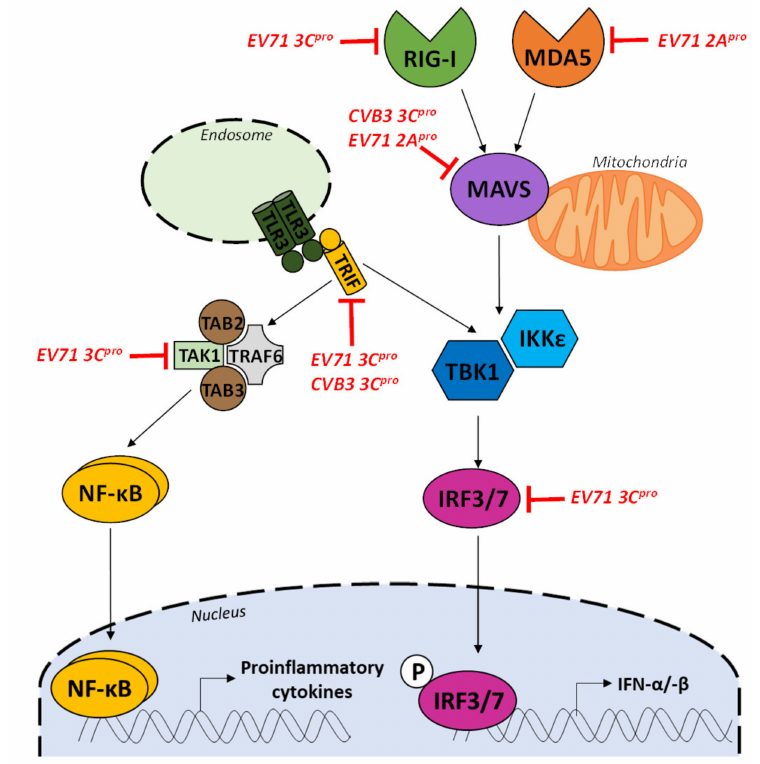
Figure 5. Group-B enterovirus proteinase activities impair type 1 signaling pathway activation in infected cells. Enterovirus proteinase 3C (3C pro ) and 2A pro are mainly involved in downregulation of type I IFN, pro-inflammatory cytokines at di ff erent stages. The interacting cellular signaling molecules with di ff erent viral proteins are indicated at each level. (MDA5: melanoma-di ff erentiation-associated protein 5, RIG-I: retinoic acid-inducible gene 1, MAVS: mitochondrial antiviral-signaling protein, TBK1: TANK-binding kinase 1, IRF3 / 7: Interferon Regulatory Factor 3 / 7, TRIF: TIR-domain-containing adapter-inducing interferon- β , TLR: toll-like receptors, TRAF6: TNF receptor-associated factor 6, TAK1: transforming growth factor- β activated kinase 1, TAB2 / 3: TGF- β Activated Kinase 2 / 3, IFNs: